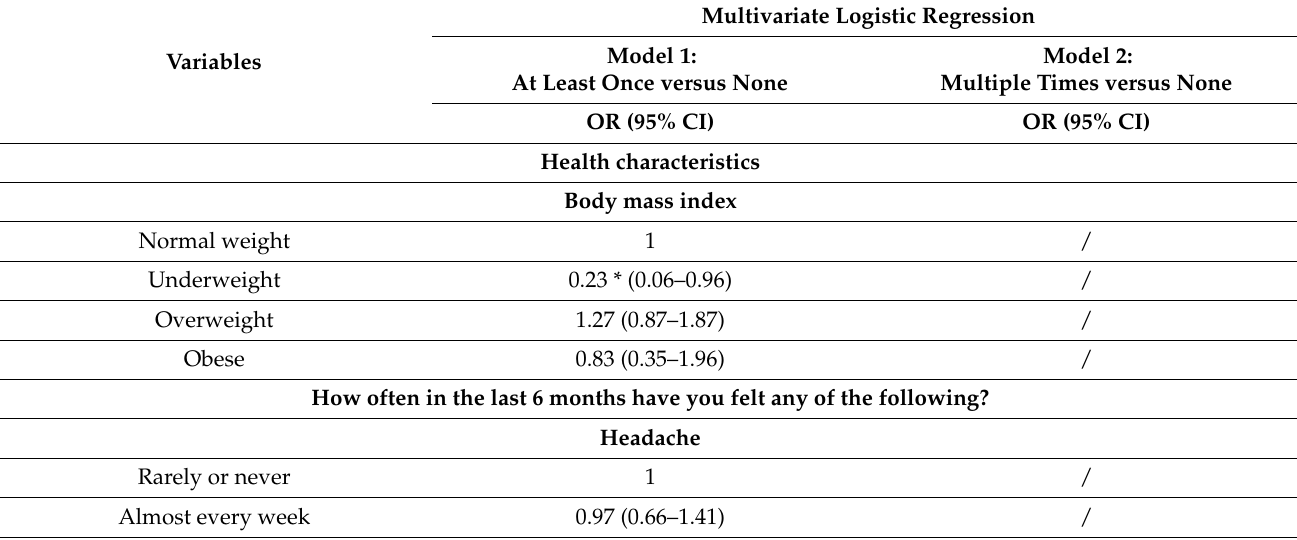
Table 4. Models of participation in bullying of school-age children in Serbia,